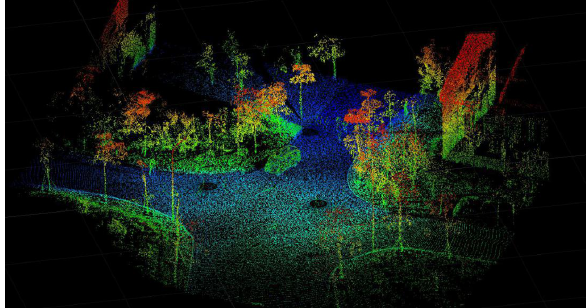
Figure 2. The rendering effect of point cloud data in the traffic